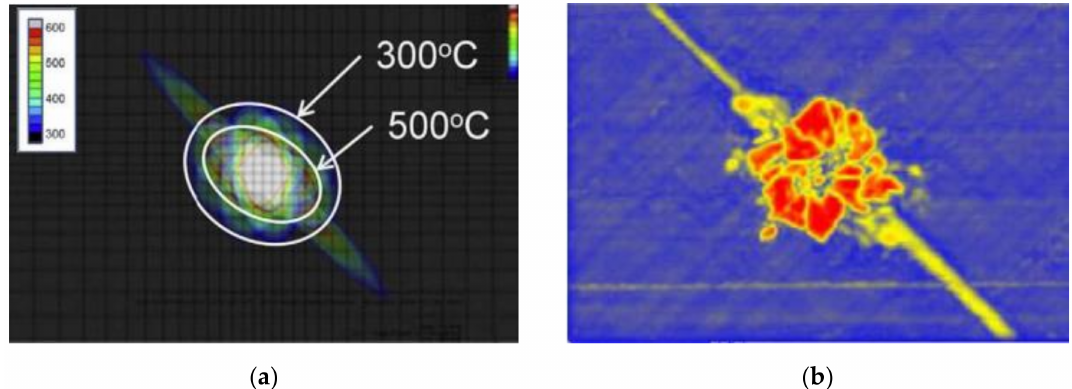
Figure 15. Results of FEA and experiments based on the whole ply analysis: ( a ) the result of FEA; ( b ) the result of the